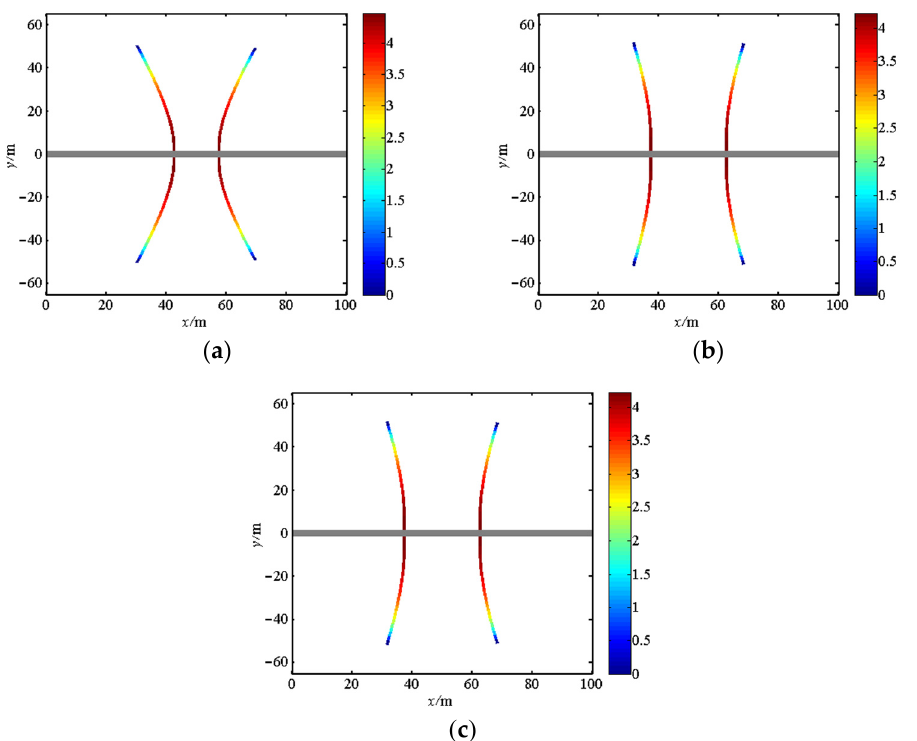
Figure 4. Fracture propagation path and fracture width distribution (mm) with different cluster spacings: ( a ) 15 m; ( b ) 25 m; ( c ) 35